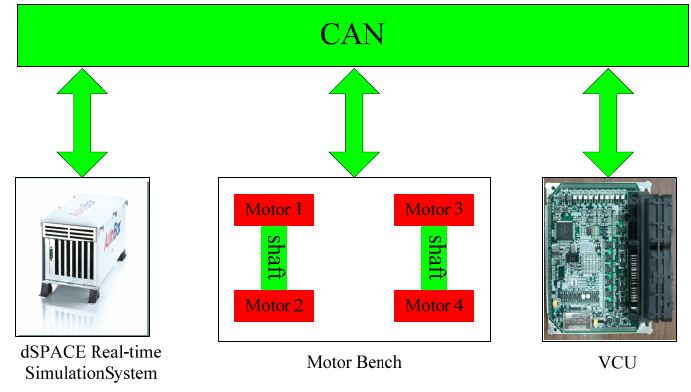
Figure 14. Structure of the test bench.